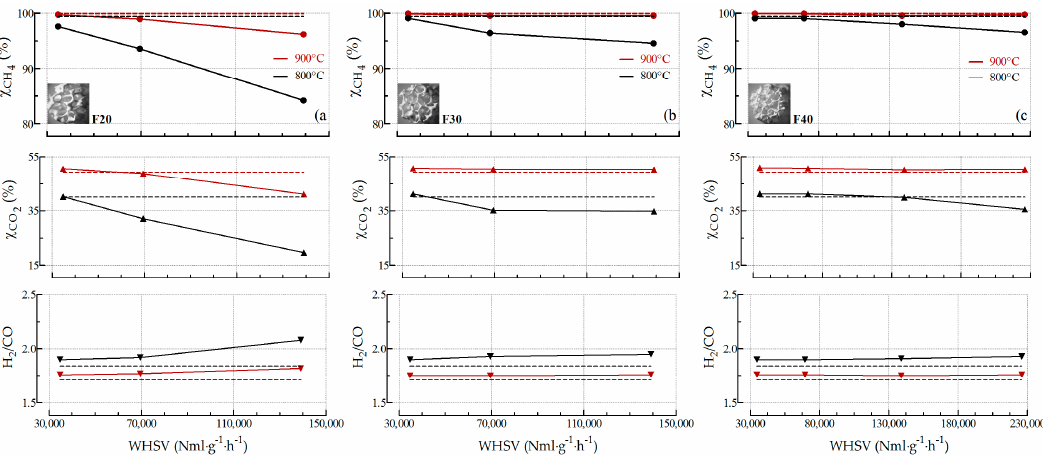
Figure 11. Biogas OSR activity (S/CH 4 = 1; O 2 /CH 4 = 0.2) over F20 ( a ), F30 ( b ) and F40 ( c ) catalysts. Influence of temperature (T SET = 800–900 ◦ C) and space velocity (WHSV = 35,000–140,000 NmL · g − 1 · h − 1 ) on CH 4 conversion, CO 2 conversion and H 2 /CO molar ratio (thermodynamic data reported as dotted